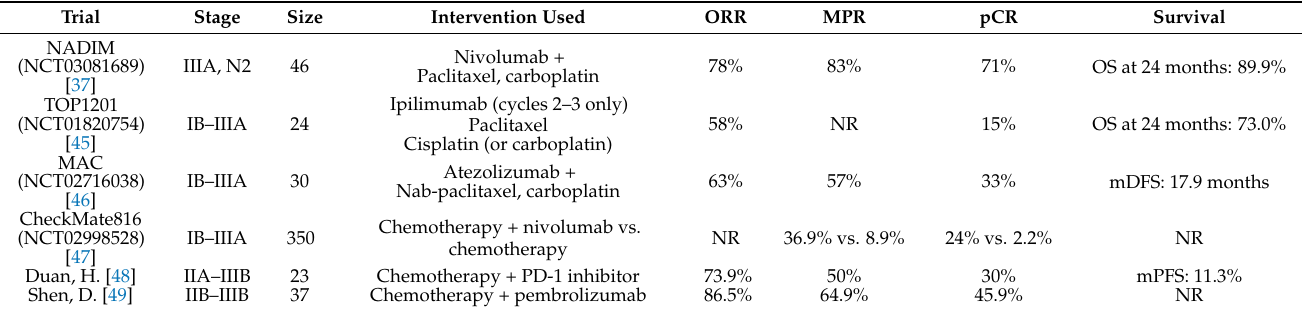
Table 4. Phase II clinical trials of neoadjuvant